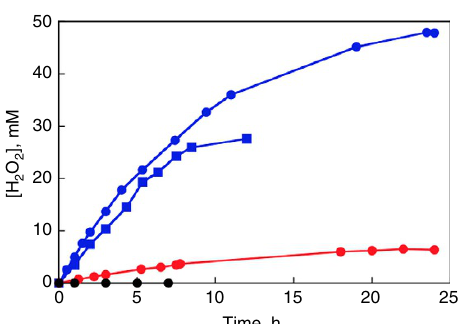
Figure 2 | Photocatalytic production of H 2 O 2 in the two-compartment photoelectrochemical cell. Time courses of H 2 O 2 production with m-WO 3 / FTO photoanode and Co II (Ch)/CP cathode in pH 1.3 water (red circle), in pH 1.3 seawater (blue circle) and in an NaCl aqueous solution (pH 1.3; blue square) under simulated 1 sun (AM 1.5G) illumination. Time course of H 2 O 2 production in the absence of Co II (Ch) on carbon paper under simulated 1 sun (AM 1.5G) illumination in pH 1.3 water is shown as